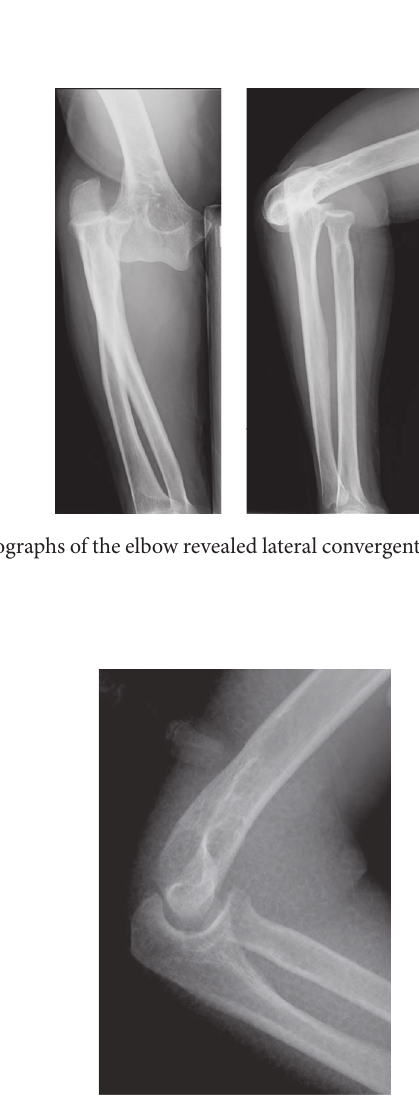
Figure 2: During reduction maneuver, the image intensifier revealed that only the ulnohumeral joint was reduced.